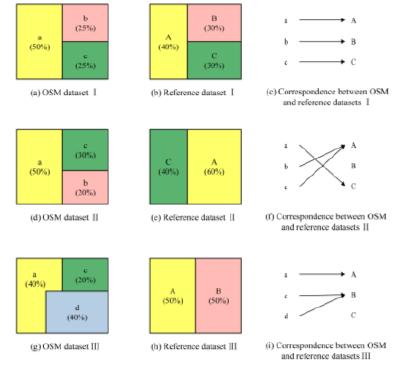
Figure 1 . The approach to establishing a correspondence between each pair of OSM and reference